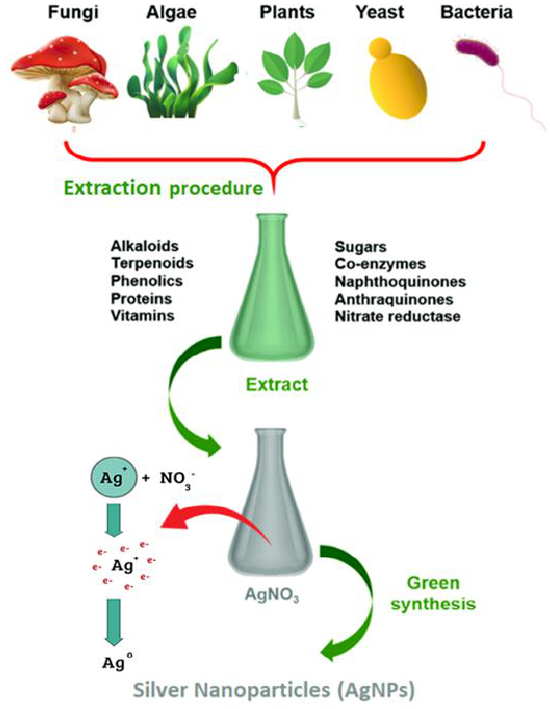
Fig. 3. Schematic diagram of procedure for “green synthesis” of silver nanoparticles using biological methods